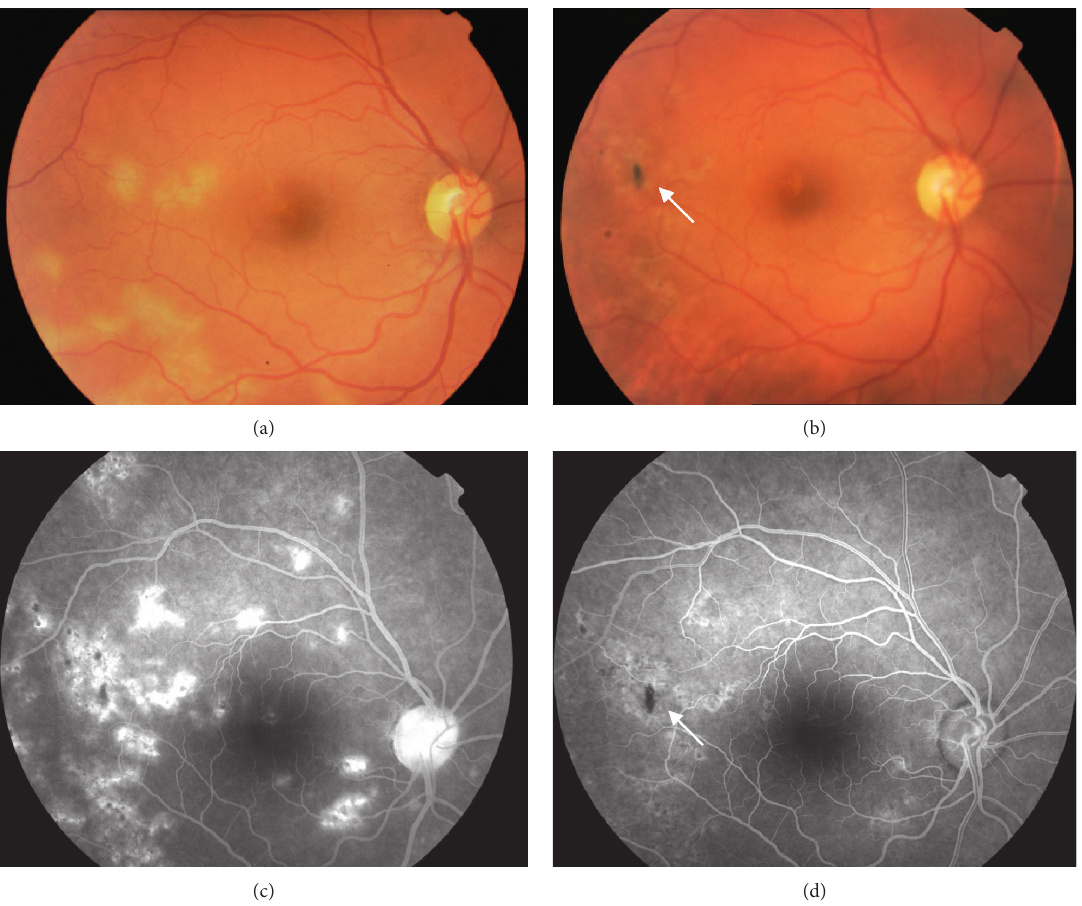
Figure 1: Ophthalmoscopic and fluorescein angiographic (FA) images of a patient with posterior tubercular uveitis. Before treatment, fundus photograph (a) and FA (b) show multiple cream-yellow active lesions with increase of choroidal fluorescence at FA. Twelve months after antitubercular treatment, fundus photograph (c) and FA (d) show fading inactive lesions and mottling pigment (white arrow) with decrease of choroidal